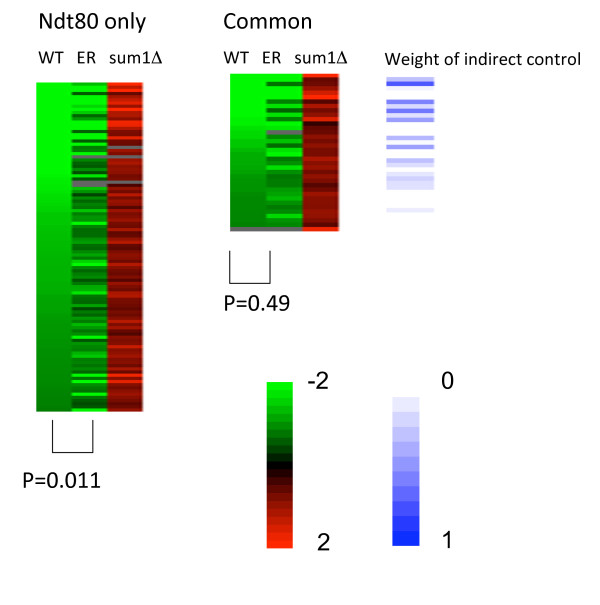
late phase repression of target genes in a strain with an inducible NDT80. repression level of common and Ndt80-only targets (difference between middle and late time points) is presented as a color coded heat-map in WT, Ndt80-ER and sum1Δ backgrounds. Note that in Ndt80-only targets WT and ER samples are significantly different, while in the common targets the repression pattern is similar. Both groups show same level of induction in the sum1Δ strain indicating that the repression of all those genes is Sum1 dependent. The metric (see Methods) capturing the relative contribution of the indirect edge in the repression of the target genes in the common group is shown with a blue color code. Note presence of genes with large weight as well as genes with small weight values in the common targets.